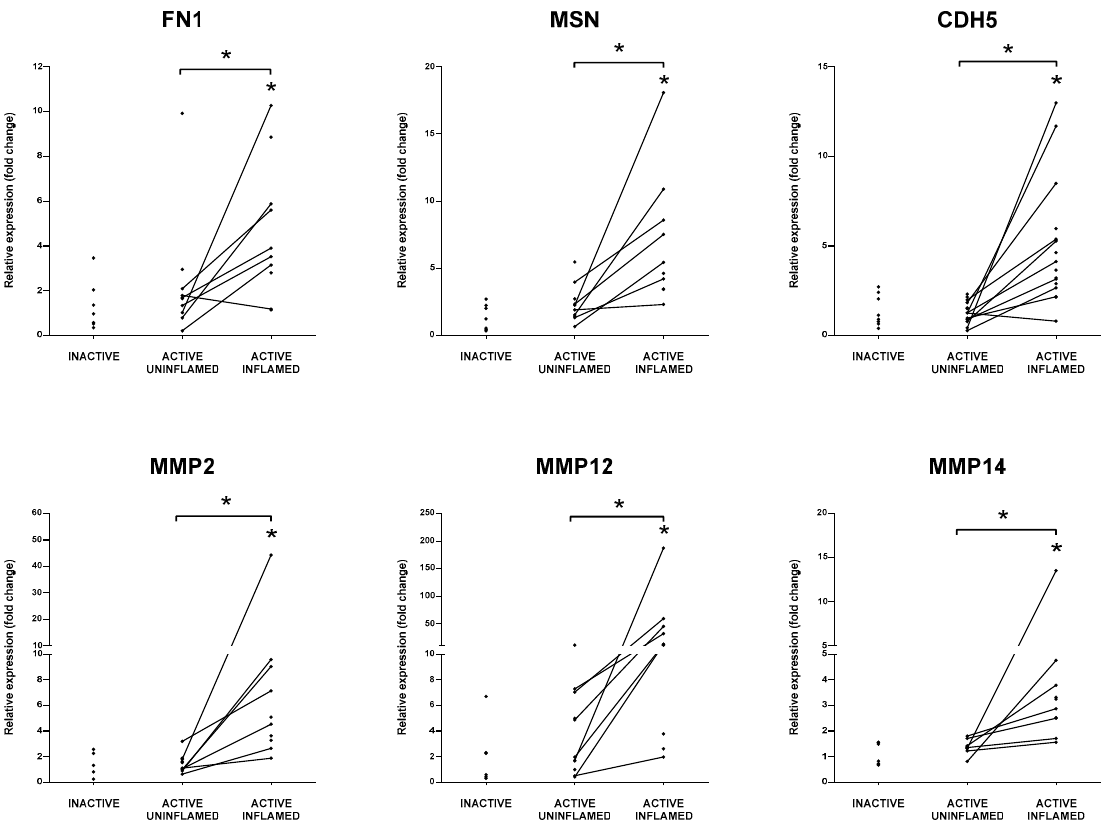
Figure 5. Collective upregulation of matrix remodelers and adhesion molecules facilitate migration of leukocytes through the endothelial cells of blood vessels. The relative gene expression of extracellular matrix component FN1, ERM family member MSN, cell adhesion molecules CDH5, matrix metalloproteinases MMP2, MMP12 and MMP14 is shown from inactive (left), active uninflamed (middle) and active inflamed (right) colon samples of IBD patients. Dots represent individual values, and the lines connect uninflamed and inflamed samples from the same IBD patient; * p < 0.05.